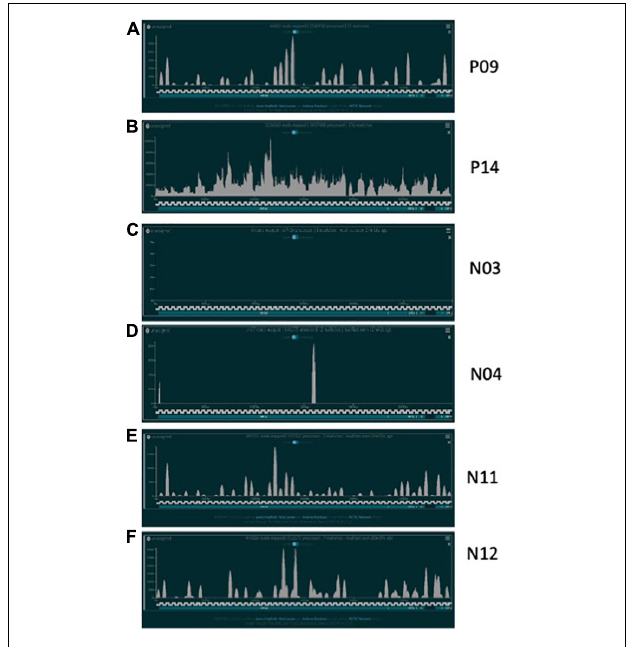
FIGURE 4 | CoV-2 Reads mapped over reference genome. Representative plots showing the number of CoV-2 reads mapping over specific regions of a CoV-2 reference genome after sequencing using the ARTIC with Rapid sequencing protocol and RAMPART analyses. (A) P09 is shown as positive sample just below the median coverage for the positive sample cohort; (B) P14 is representative of high coverage samples; (C) N03 is a negative sample with zero CoV-2 reads identified; (D) N04 is a negative sample with possible non-specific amplification or contamination; (E,F) are two RT-PCR negative samples with 50–60% CoV-2 genome coverage following